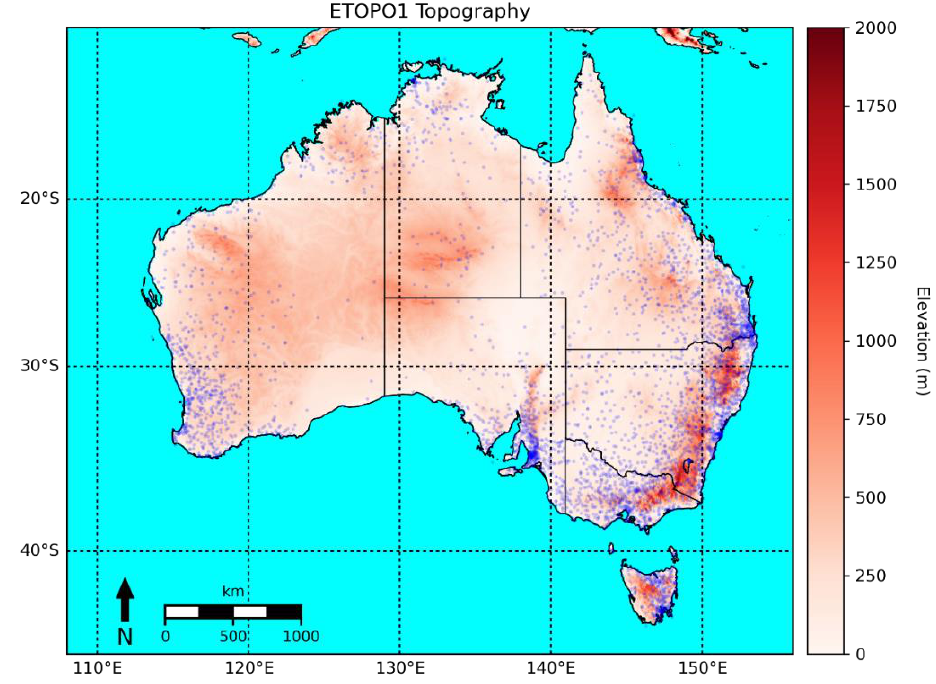
Figure 1. Typical rain gauge network coverage in Australia. Rain gauge locations are depicted by the blue dots while topography is represented by the shading. The main topographical feature is the Great Dividing Range along the east coast of the country.